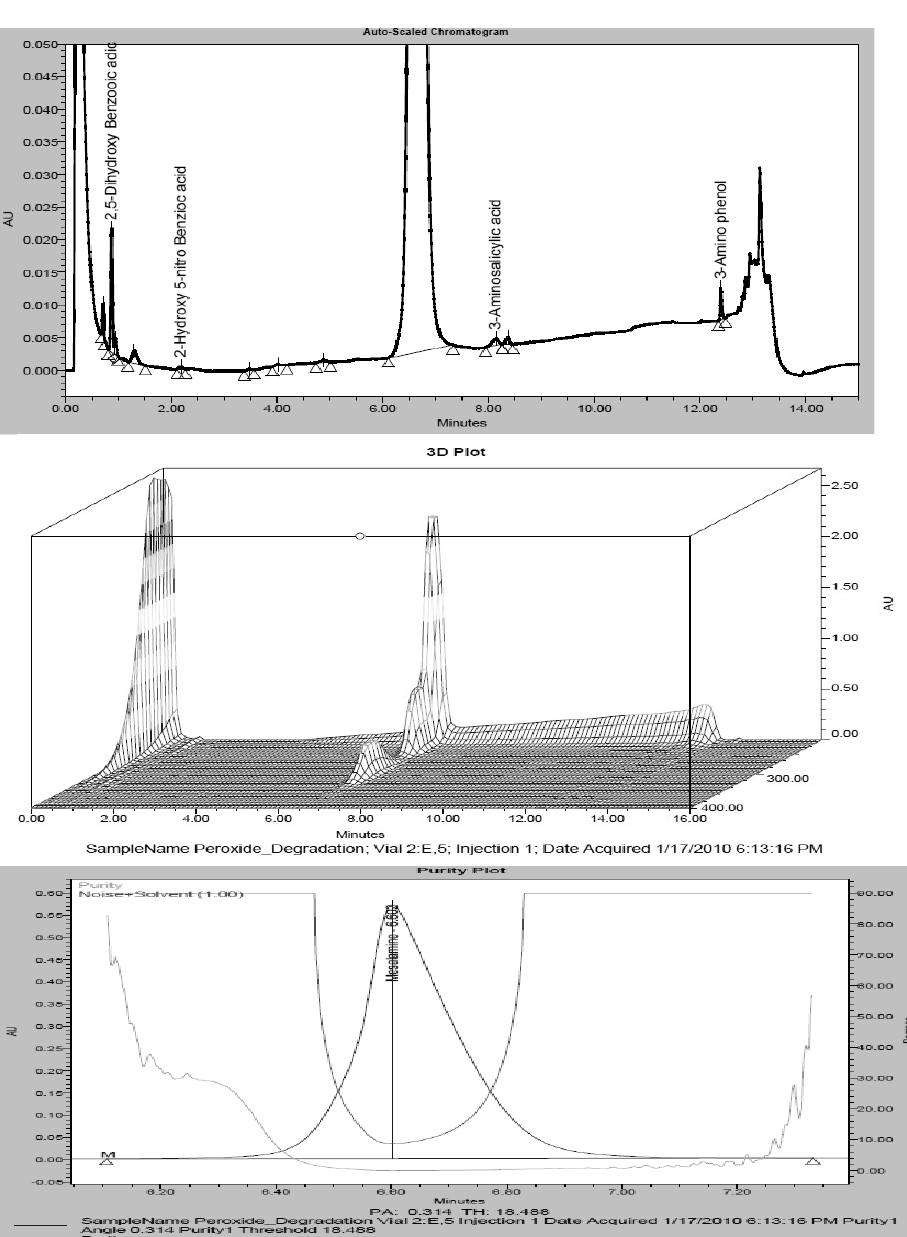
Figure 6. Chromatogram of peroxide degraded tablet sample with its 3D plot and purity plot.